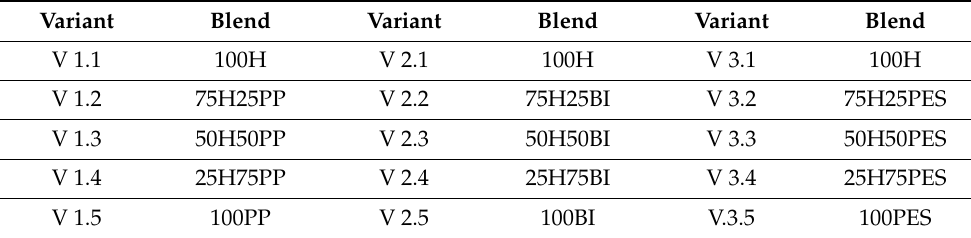
Table 2. Working